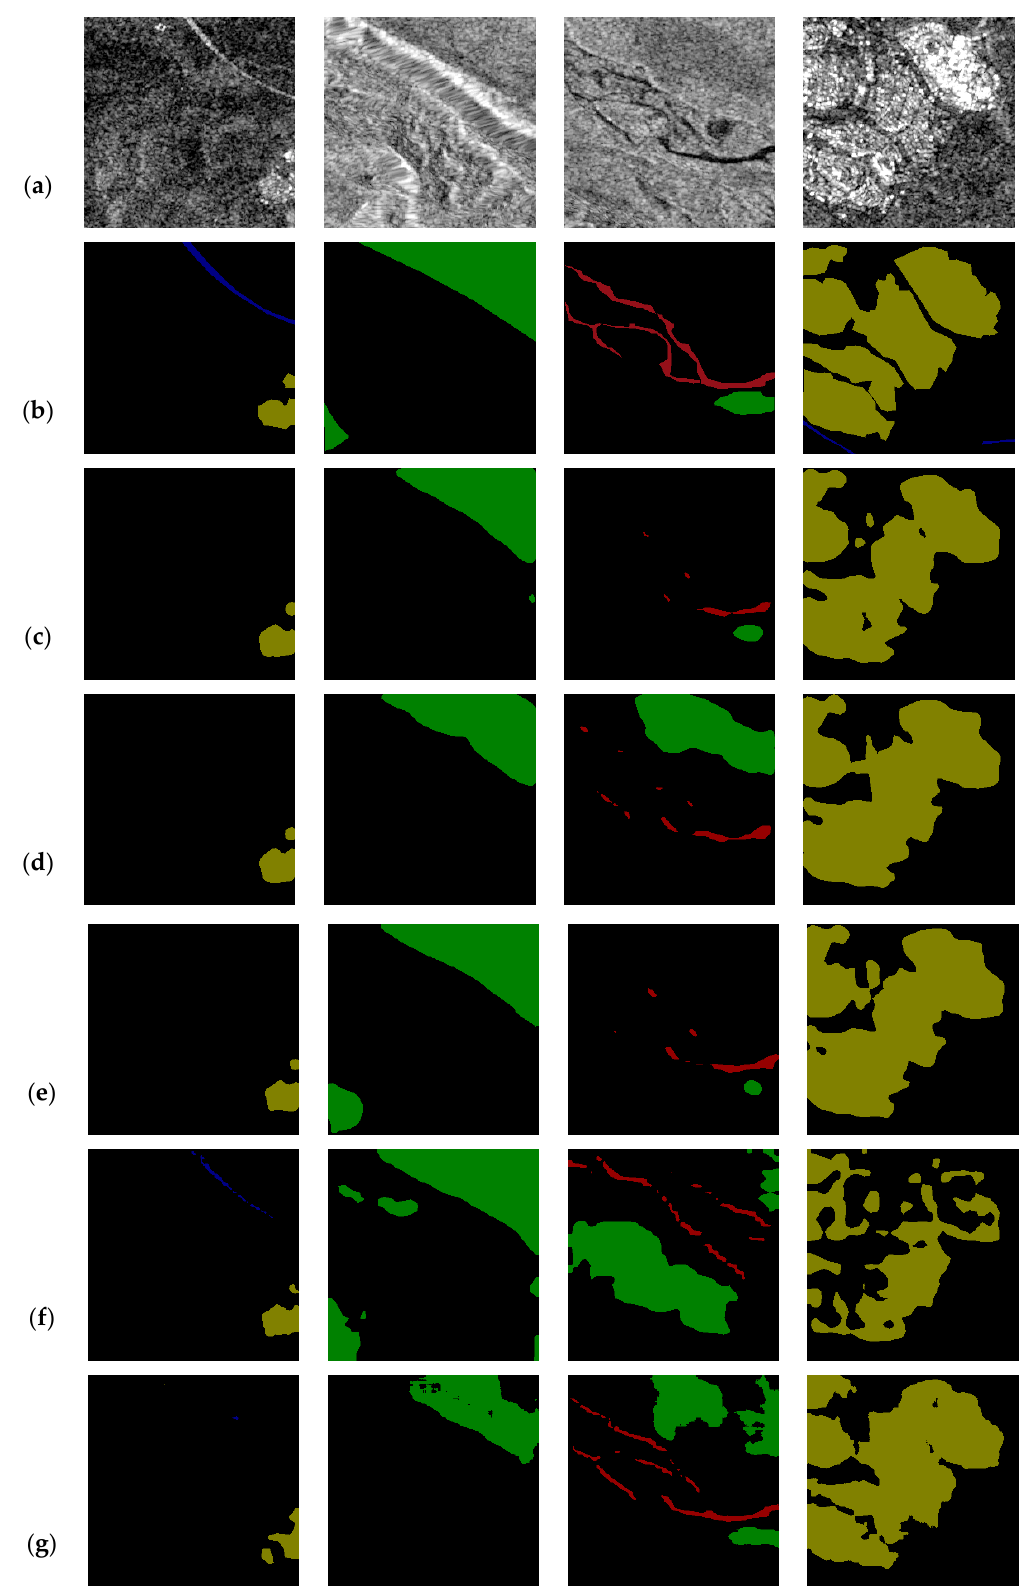
Figure 5. The results of different networks: ( a ) SAR images; ( b ) ground truth; ( c ) Deeplabv3+–drn output; ( d ) Deeplabv3+– ResNet output; ( e ) Deeplabv3+–Mobilenetv2 output; ( f ) PSPNet output; ( g ) FCN output.